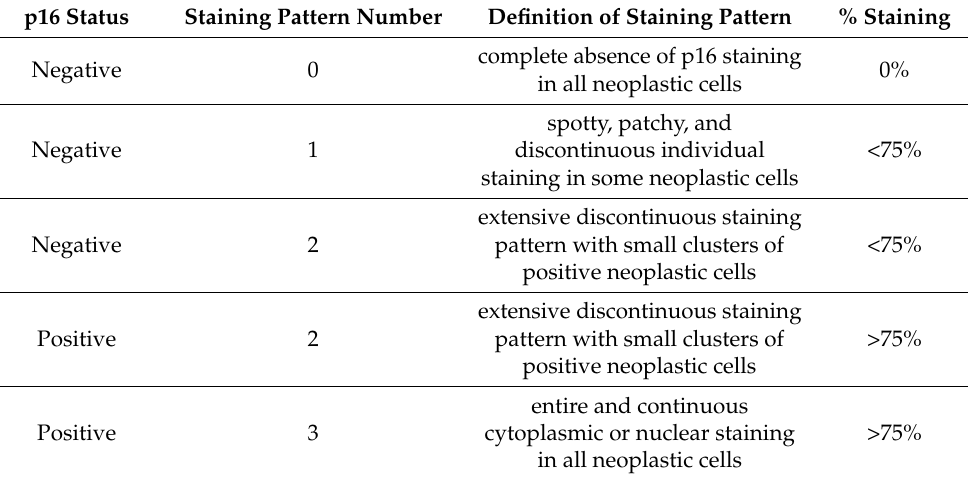
Table 1. Hybrid system (HS) for analyzing p16 IHC. A combination of the staining pattern [13,14] and the percent staining was used to determine if p16 status was positive or negative. When more than 1 pattern was observed in the same tumor, the highest one was considered as representative of the whole